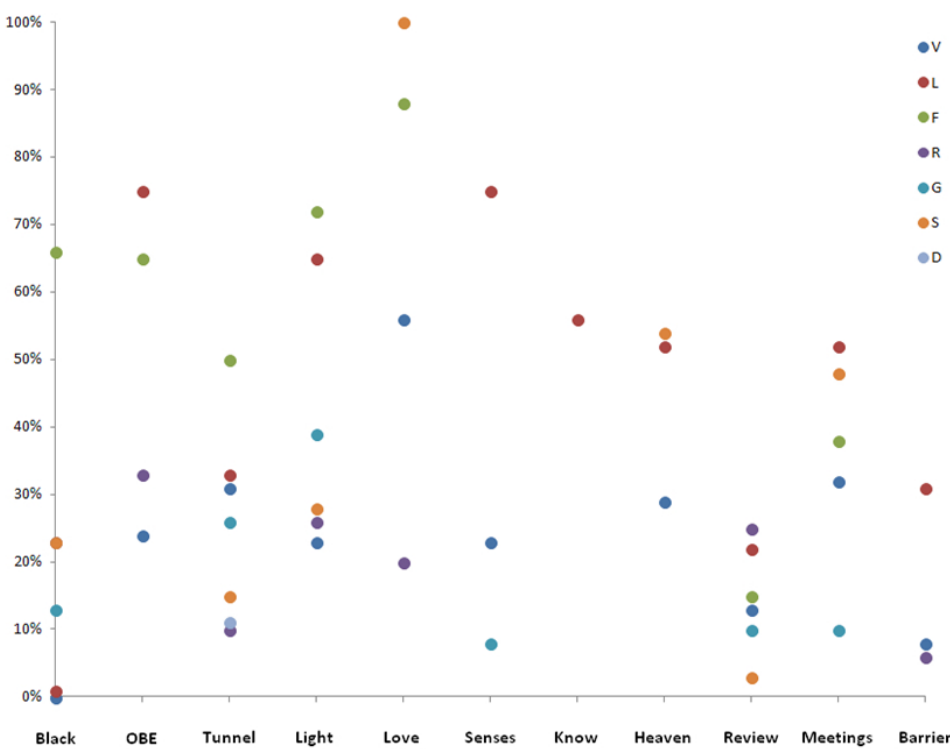
Figure 1. This scattergram plots the percentage (vertical axis) of subjects experiencing the varied features of near-death and out-of-body experiences (ND/OBE) (~800 as recorded in the works of prominent authors in this field): as far as is possible, these data have been extracted and forged into the major experiential groupings (along the horizontal axis). Contrary to expectation, there is no obvious correlation, symmetry or uniformity among any of these categories. Extraordinarily, they point to the marked randomness of the experiences reported for this large cohort of subjects. This is the first occasion on which these results have been drawn together in one composite diagram. What is quite evident is that these cumulative data fail to underpin the smoothed accounts of ND/OBE phenomenology which many of these authors are keen to enunciate and present to the public and media.